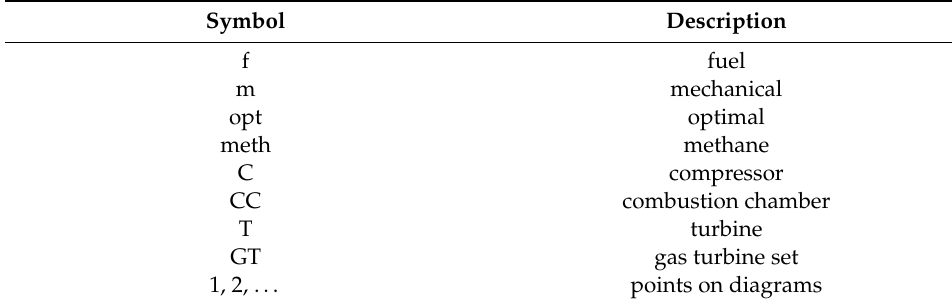
Table 2. List of used subscripts.